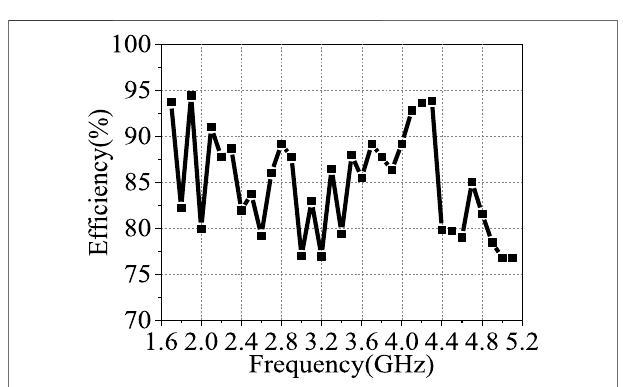
FIGURE 11 | Measured ef fi ciency of the proposed antenna.